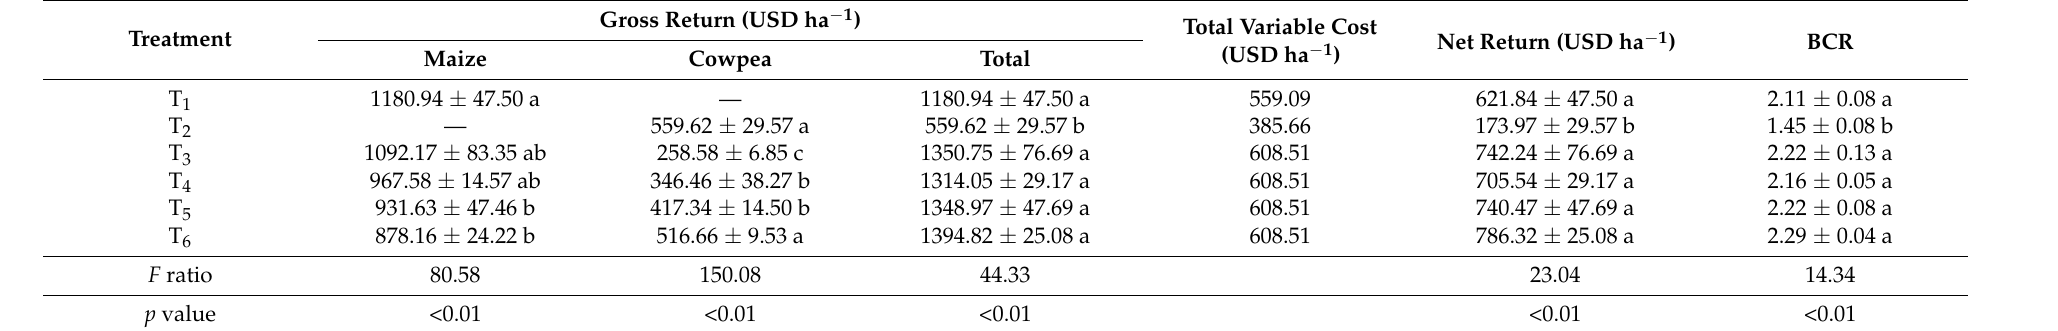
Table 6. Economic returns from maize-cowpea intercropping